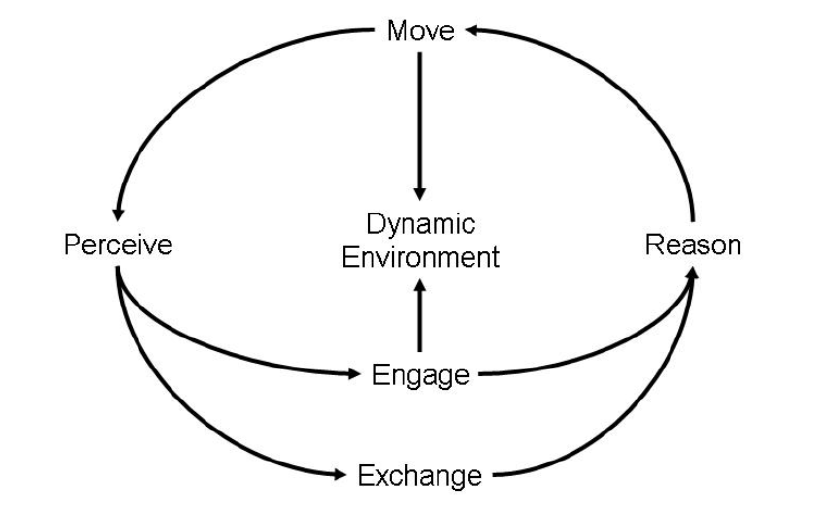
Figure 3 – Relationship model for a simple battlefield simulation (Smith, 2007) Рис . 3 – Простое моделирование поля боя (Smith,